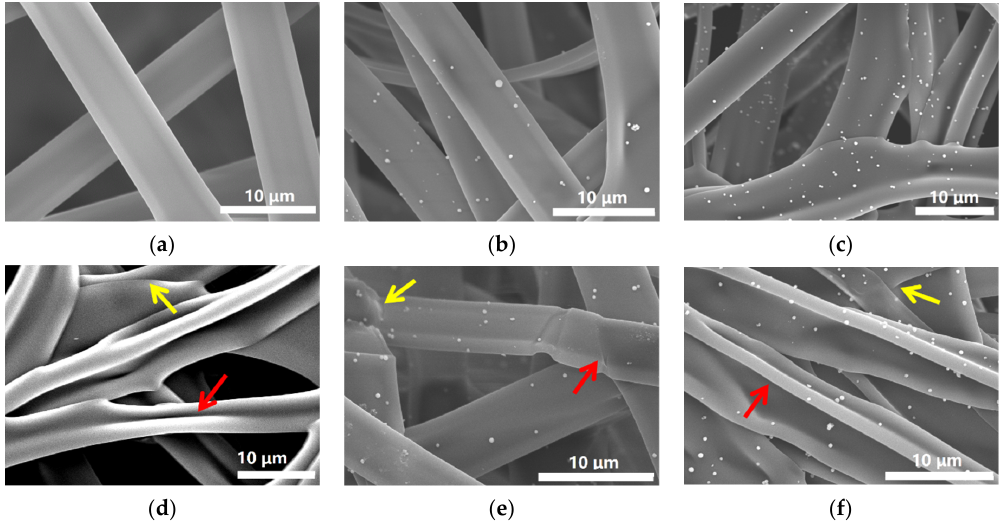
Figure 3. SEM images of ( a ) GZ0’, ( b ) GZ1’, ( c ) GZ2’, ( d ) GZ0, ( e ) GZ1 and ( f ) GZ2.